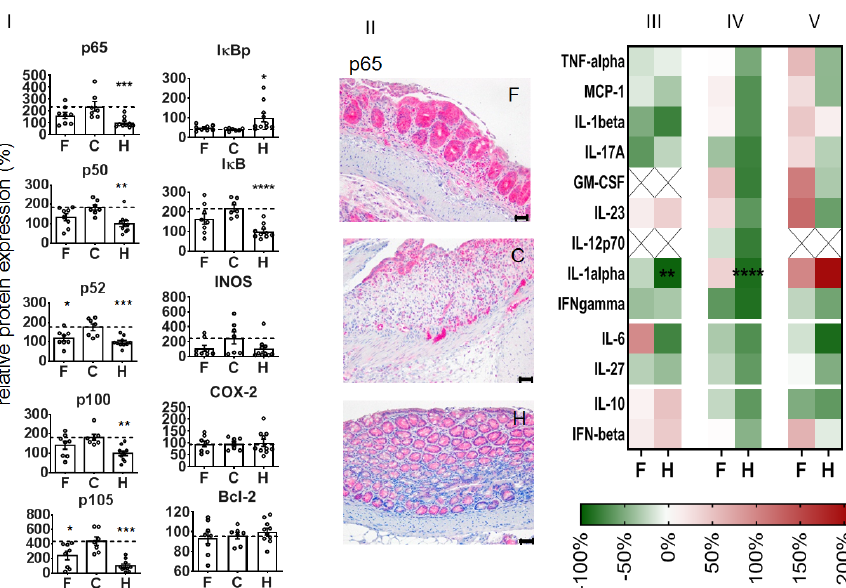
Figure 5. Impact of NPs on p65 NF- κ B and related proteins in whole colon tissue during induction of DSS-mediated colitis in mice at recovery day 4. ( I ) Protein expression in whole colon tissue. ( II ) Representative microscopic pictures from immunohistochemical tissue staining showing the distribution of p65 (red, hematoxylin counterstaining: blue, scale bars: 50 µ m). ( III – V ) Heat maps of cytokine expression in whole colon tissue ( III ), in ex vivo cultivated colon tissue, recovery day 5 ( IV ), and in blood plasma ( V ). Mediator secretion was related to levels in animals with colitis (in %, no NP administration); X—cytokine level below detection threshold. F—NPs in animals with colitis, C—colitis only (no NPs), H—healthy animals (no NPs). Mean ± standard error of the mean; n = 6 to 10. Significant difference compared to group C with p < 0.05 (*), p < 0.01 (**), p < 0.001 (***), and p < 0.0001 (****).